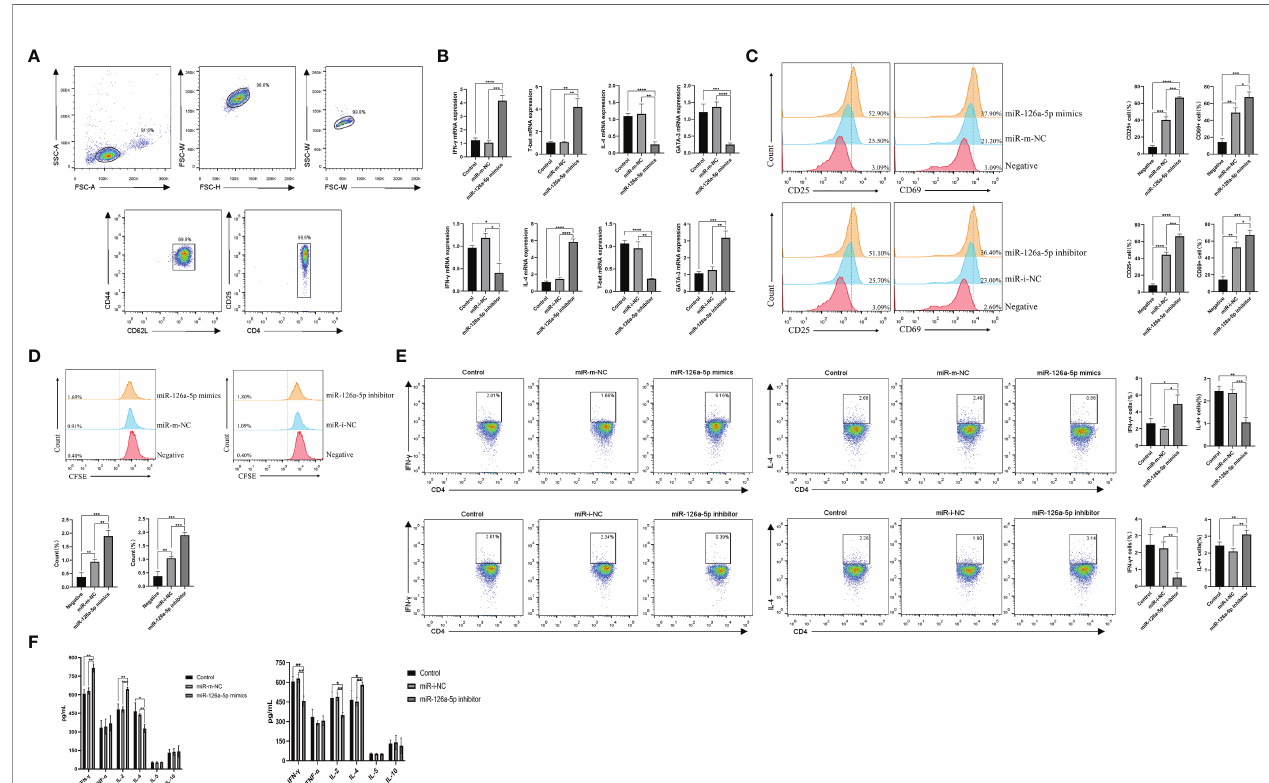
FIGURE 2 | miR-126a-5p promotes the differentiation of naive CD4 + T cells into Th1. (A) The puri fi cation rate of naive CD4 + T cells from lymphocytes sorted by magnetic beads with fl ow cytometry. (B) Expression of IFN- g , T-bet, IL-4, and GATA-3 in naive CD4 + T cells transfected with miR-126a-5p mimics or miR-126a-5p inhibitor was examined by qRT-PCR. (C) Flow cytometry determination of activation indicators CD25 and CD69 after transfection with miR-126a-5p mimics or miR- 126a-5p inhibitor in naive CD4 + T cells. (D) CFSE assay of the proliferation levels in naive CD4 + T cells after transfection with miR-126a-5p mimics or miR-126a-5p inhibitor. (E) Flow cytometry measurement of IFN- g and IL-4 expression after transfection with miR-126a-5p mimics or miR-126a-5p inhibitor in naive CD4 + T cells. (F) ELISA detection of IFN- g , TFN- a , IL-2, IL-4, IL-5, and IL-10 expression in culture supernatants after transfection with miR-126a-5p mimics or miR-126a-5p inhibitor in naive CD4 + T cells. * P < 0.05, ** P < 0.01, *** P < 0.001, **** P <